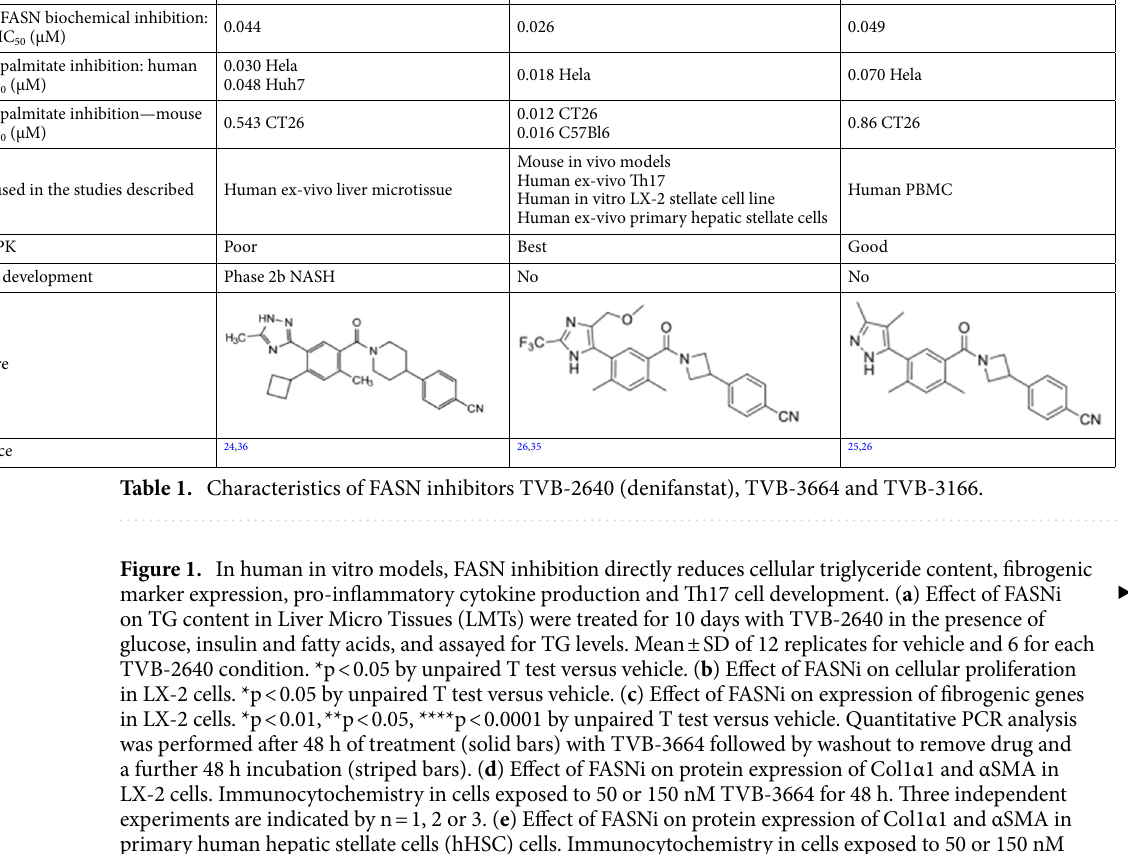
NASH patients have increased levels of ceramides that are associated with insulin resistance, inflammation, and production of reactive oxygen species 15–17 . Increased intrahepatic fat and the generation of lipotoxic metabolites promote the progression of NAFLD by damaging hepatocytes, stimulating inflammatory responses, and activat- ing HSCs. Fourth, palmitate directly activates the Nod-like receptor (NLR) family pyrin domain containing 3 (NLRP3) inflammasome. In human macrophages palmitic acid treatment leads to pro-inflammatory cytokine production 18 . In rat HSCs, administration of palmitic acid activates the NLRP3 inflammasome via the TLR4 pathway and leads to activation, proliferation and expression of pro-fibrogenic genes such as αSMA, Col1α1, TIMP1 and TGF-beta 19 . Palmitate administration can directly cause liver injury and NASH in mouse models 20 . The DNL pathway is also important for development of pro-inflammatory T helper (Th17) cells 21,22 , which are increased in the liver of NASH patients compared to healthy liver and may contribute to stellate cell activation and liver damage. This may provide another mechanism for FASN inhibition to decrease liver inflammation. Based on the disease-promoting properties of the DNL pathway and palmitate, FASN is an attractive drug target to attenuate hallmarks of NASH pathogenesis driven by hepatocytes, immune cells and HSCs. Early tool FASN inhibitors included natural products such as cerelulin and platensimycin, and a covalent inhibitor named C-75 which have been useful to explore the biology of FASN in a range of preclinical models, but have off-target activities and are not suitable for clinical development [review, 23 ]. We tested potent small molecule FASN inhibi- tors including TVB-2640 (denifanstat) in liver, immune and fibrogenic cells ex vivo, and in mouse models of NASH and liver fibrosis. The efficacy observed underscores the value of FASN inhibition in NASH, and provides insight into mechanism of action. These results support the rationale underlying clinical testing of denifanstat, a first in class FASN inhibitor currently in Phase 2 for NASH.